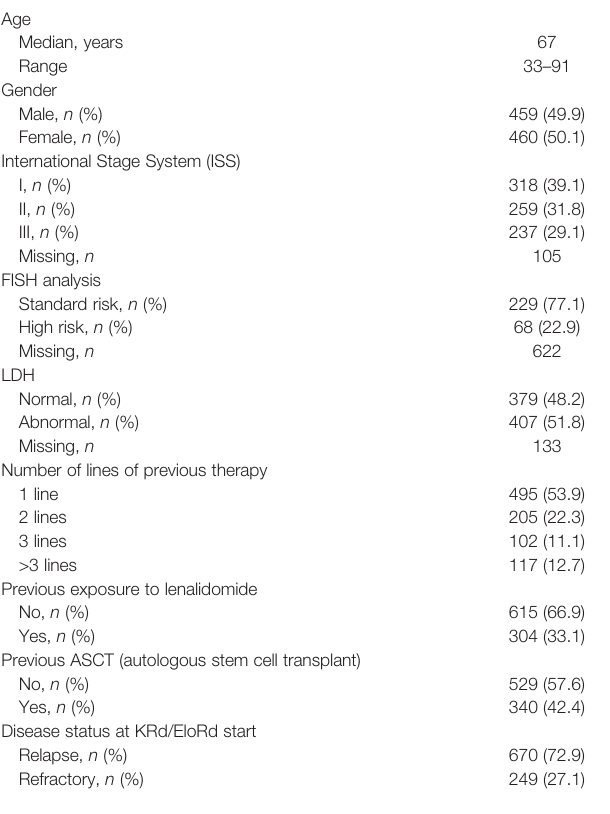
TABLE 1 | Clinical features of 919 relapsed/refractory multiple myeloma (RRMM) patients treated with car fi lzomib, lenalidomide, and dexamethasone (KRd) or elotuzumab, lenalidomide, and dexamethasone (EloRd) as salvage regimens in a real-life